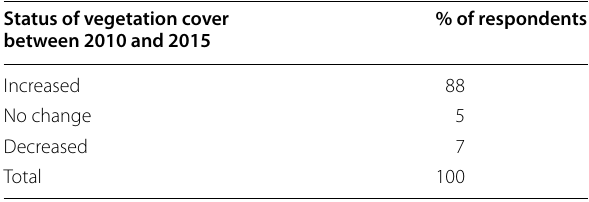
Table 6 Farmers’ perception of the vegetation covers in the study area (N 121) =